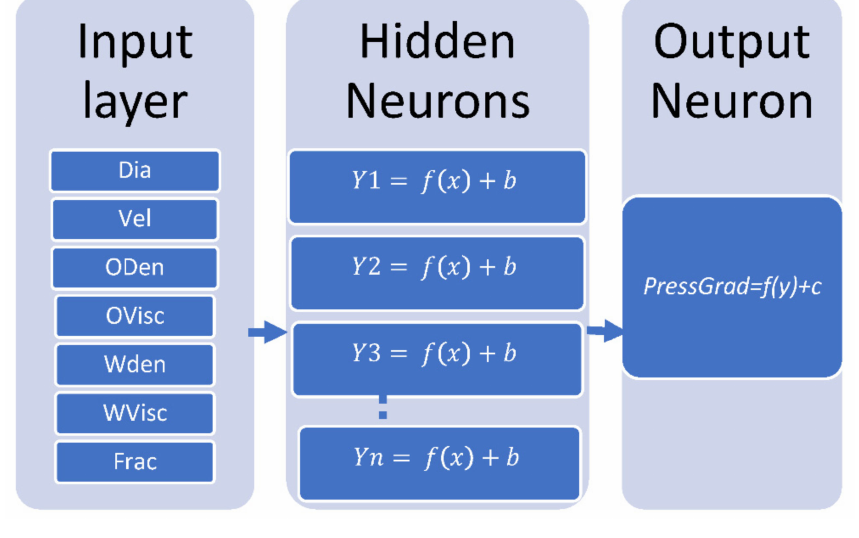
Figure 3. Structure of ANN Process.